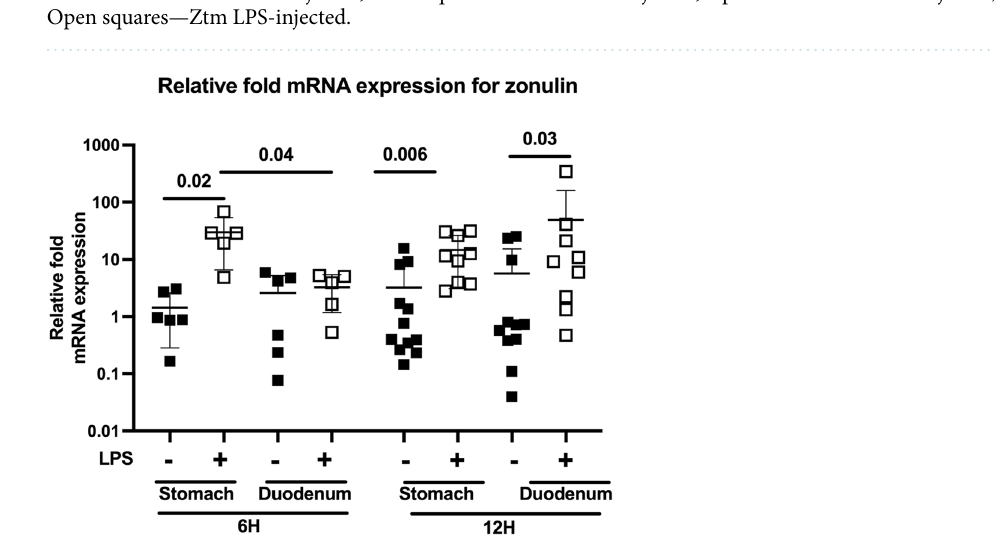
Figure 5. Gastric and duodenal mRNA expression of zonulin. Relative fold mRNA expression are presented for visual representation, and delta cycle threshold (dCT, target gene CT – housekeeping gene CT) values were utilized for statistical analyses using one-way ANOVA, p < 0.05. Individual values per mouse are represented. Filled squares—Ztm vehicle-injected; Open squares—Ztm